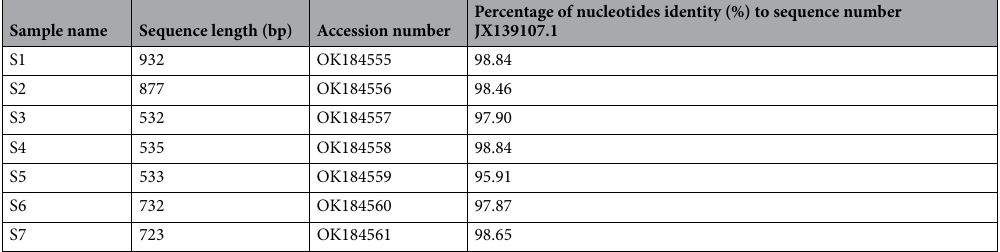
Table 2. Similarity results of the PCR products